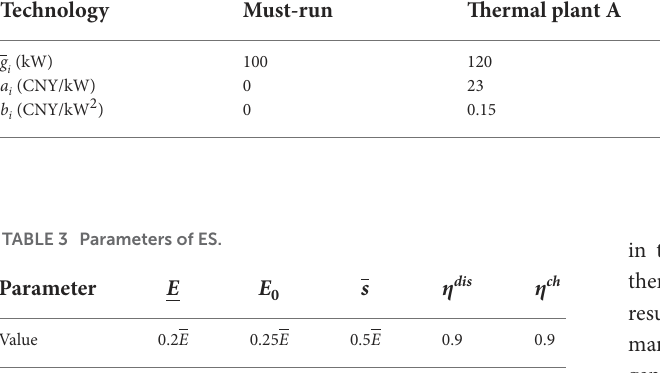
FIGURE 8 Normalized wind output and demand in five representative days.